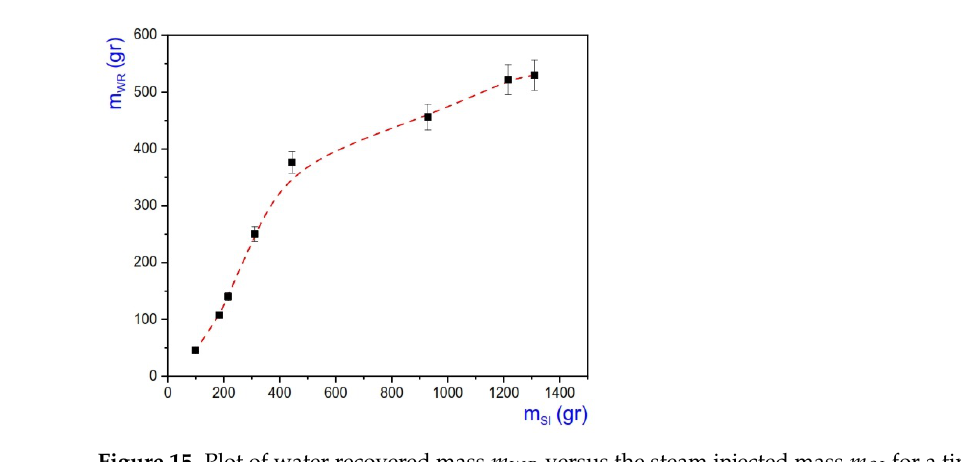
Figure 15. Plot of water recovered mass m WR versus the steam injected mass m SI for a time period of ∆ t = 1800 s.